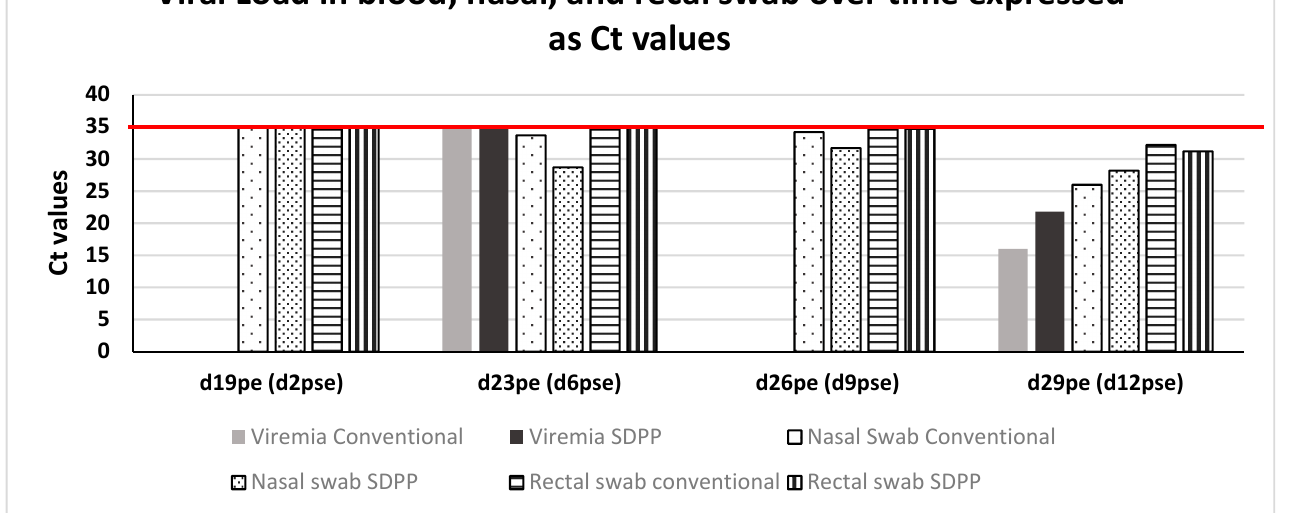
Figure 4. PCR results in blood, nasal and rectal swabs on di ff erent days during the study. Results expressed in Ct values/mL The red color bar indicated the limit of detection of qRT-PCR for positive samples.